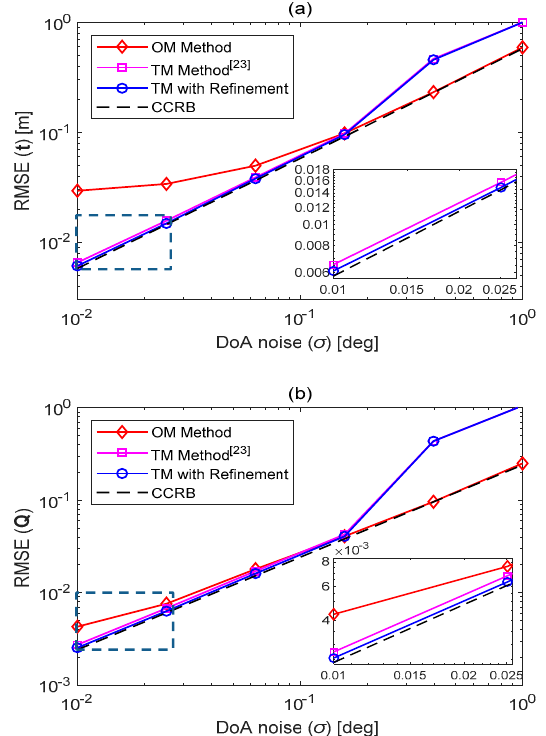
Figure 5. Comparison of RMSEs of ( a ) the estimated translation vector and ( b ) the estimated rotation matrix, when 𝐷 = 2 m.